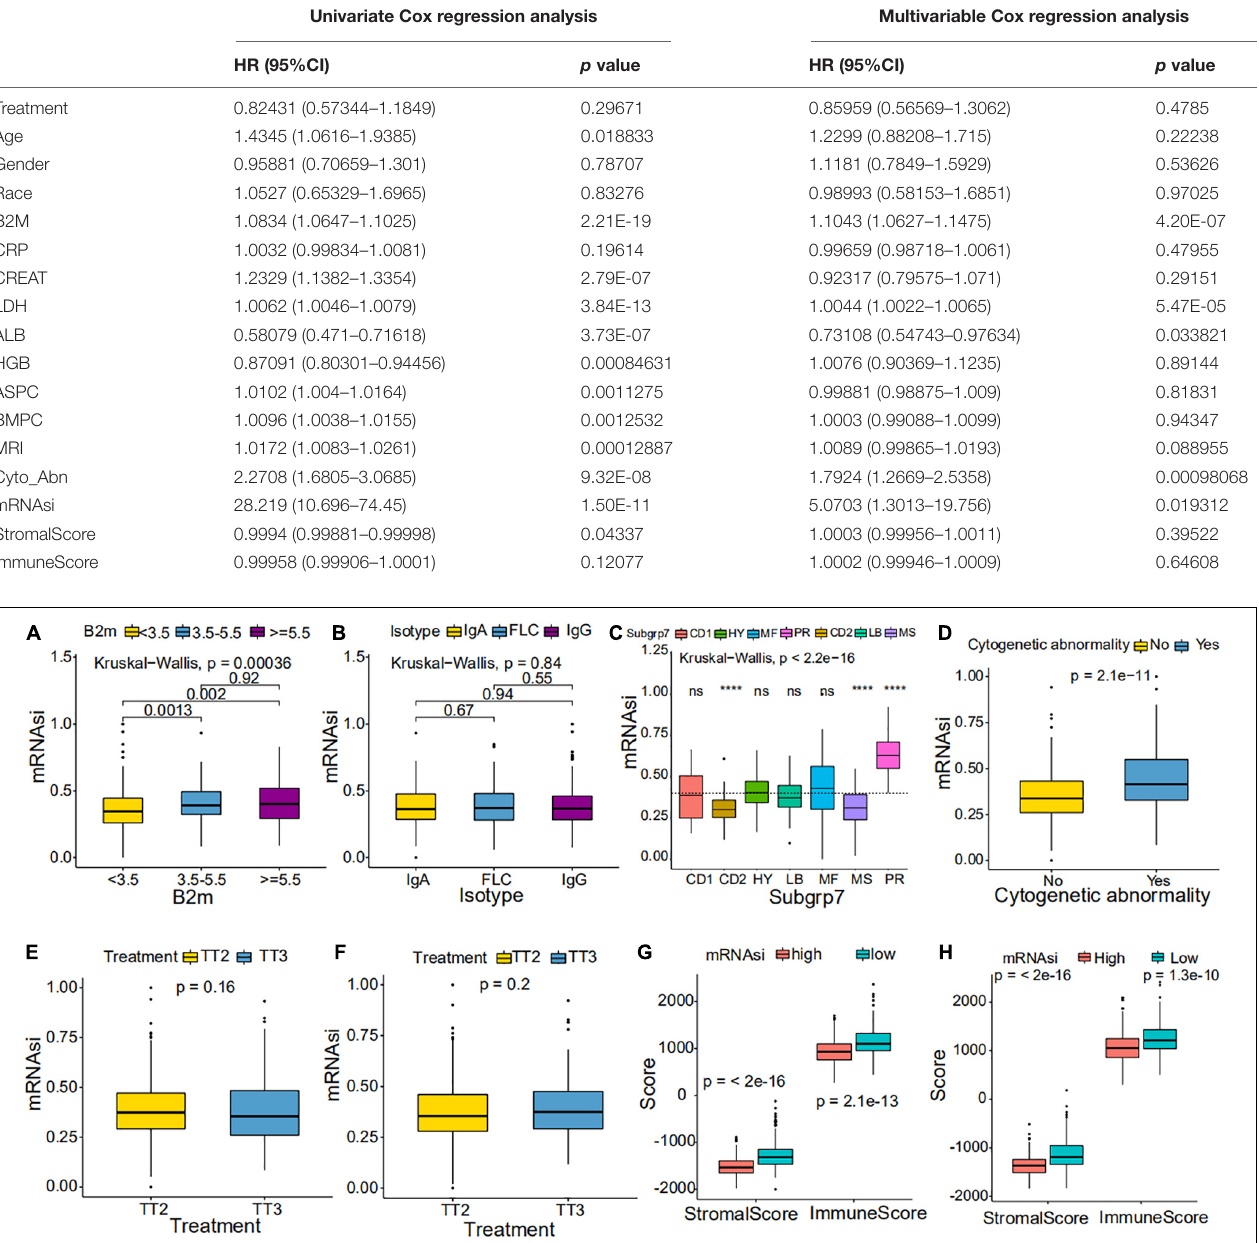
TABLE 2 | Univariate and multivariable cox regression analysis of clinical features and OS in the GSE24080 cohort of MM patients. Univariate Cox regression analysis Multivariable Cox regression analysis